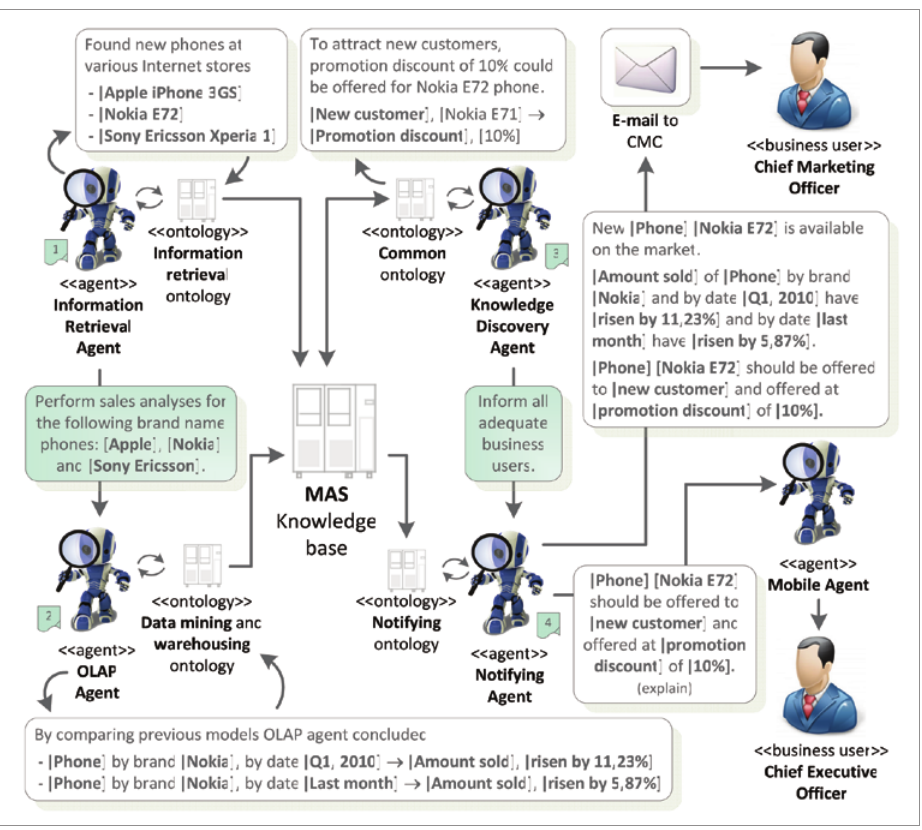
Fig. 7. Case study of using DSS-MAS in mobile phone